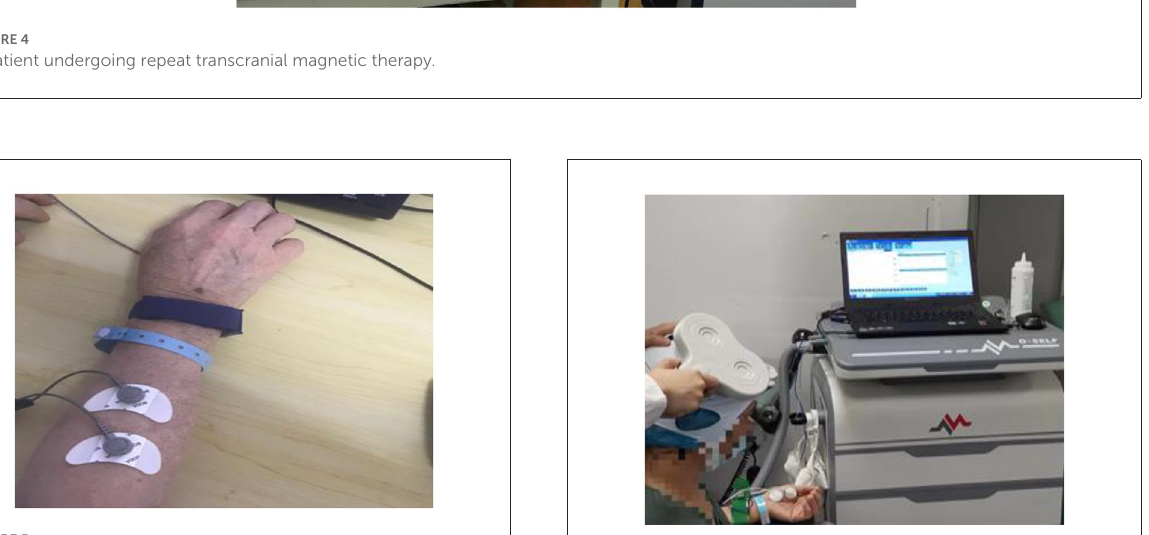
FIGURE5 Measurement of surface electromyography of extensor carpi dorsi muscles.